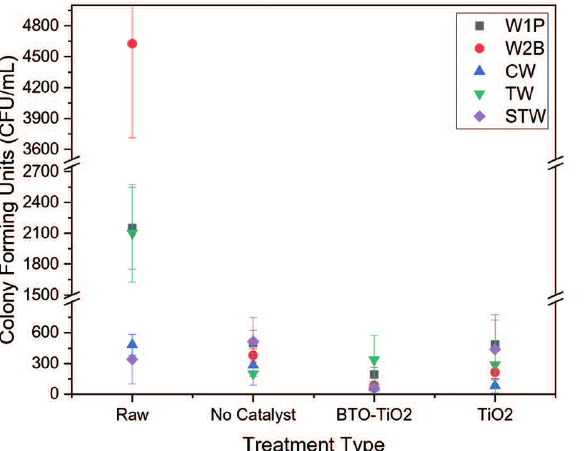
Figure 27. Colony forming units in water from different sources in India (W1P, W2B, CW, TW, STW) without treatment (raw), after 5h of storage in a bottle in sunlight (no catalyst), and after treatment with (doped) photocatalytically active glass spheres (BTO-TiO 2 and TiO 2 ) for 5h in a bottle in sunlight. (Reprinted/adapted with permission from Ref. [86]).